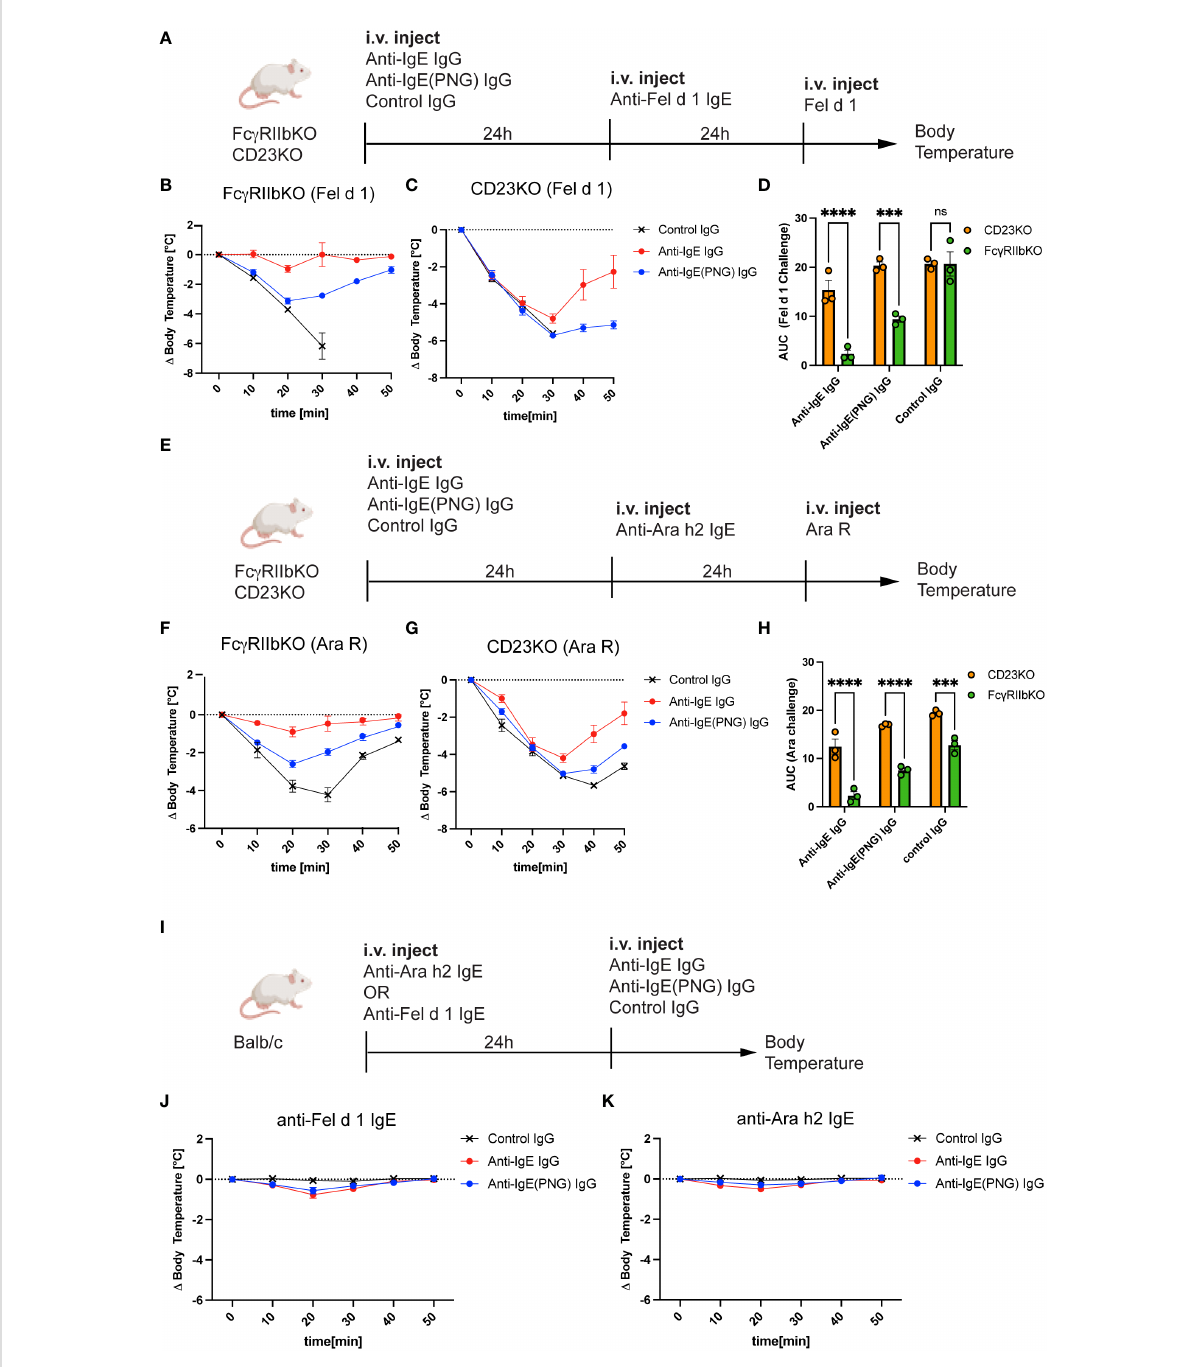
FIGURE 4 CD23 is important for the protection but not Fc g RIIb. Schematic challenge overview with Fel d 1 and Ara R as an allergen, respectively, in Fc g RIIbKO and CD23KO mice (A, E) . (B, C) Shows the decrease in body temperature (delta) over time following challenge with Fel d 1 after passive immunization with anti-IgE IgG, anti-IgE(PNG) IgG, or control IgG, in Fc g RIIb KO (B) mice and in CD23KO mice (C) . AUC comparison between of Ara R challenged mice are displayed in (D) . Decrease in body temperature (delta) over time following challenge with Fel d 1 after passive immunization with anti-IgE IgG, anti-IgE(PNG) IgG, or control IgG, in Fc g RIIb KO mice (F) , in CD23KO mice (G) . AUC comparison between of Fel d 1 challenged mice are displayed in (H) . Experimental setup to analyze the anaphylactic potential of the anti-IgE IgG antibodies (I) . (J, K) show the drop of bodytemperature of mice sensitized with anti-Fel d 1 (H) or anti-Ara h2 (I) IgE and challenged with the anti-IgE IgG antibodies. The signs for statistical signi fi cance are p ≤ 0.001 (***), and p ≤ 0.0001